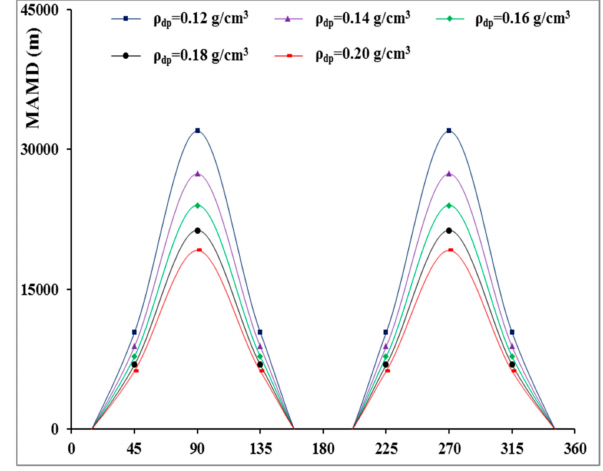
Figure 11. MAMD with ∆ p p / p p = 0.6.